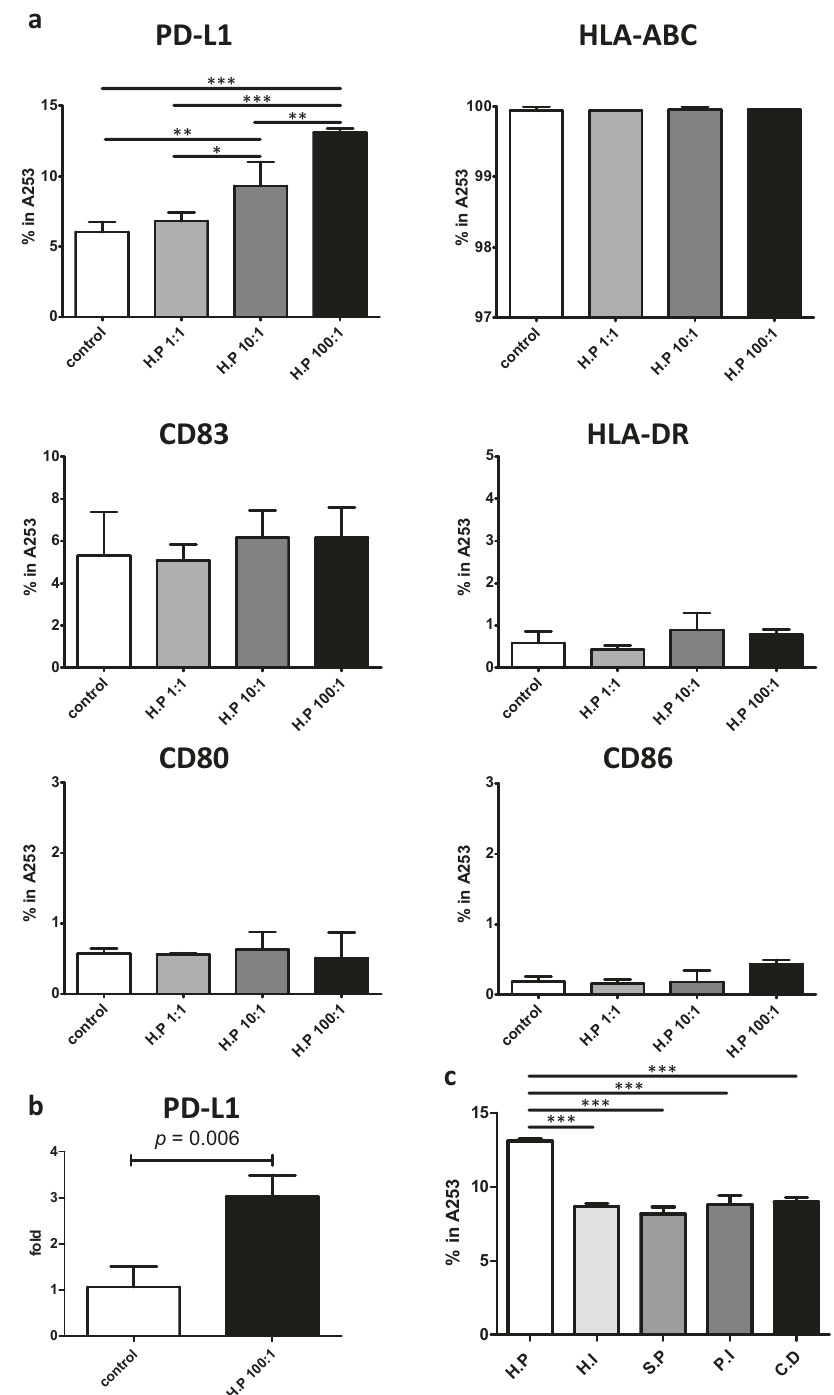
Fig. 4 Increased expression of PD-L1 in H. parain fl uenzae -treated A253 cells. a Increased percentage of cells expressing surface PD-L1 in a dose-dependent manner. One-way ANOVA p < 0.001; post hoc analysis, * p < 0.05, ** p < 0.01, *** p < 0.001; percentages of cells with surface expression of HLA-ABC, CD83, HLA-DR, CD80, and CD86 were not changed. b Increased PD-L1 mRNA expression in H. parain fl uenzae - treated A253 cells. t test p = 0.006. c Comparison of percentages of A253 cells expressing PD-L1 following treatment with various bacteria at a bacteria-to-cell ratio of 100:1. H.P Haemophilus parain fl uenzae , H.I Haemophilus in fl uenzae , S.P Streptococcus pyogenes , P.I Prevotella intermedia , C.D Clostridium dif fi cile . One-way ANOVA, p < 0.001; post hoc analysis, *** p < 0.001; error bars stand for one standard error. Representative dot plots are provided in Supplementary Fig.